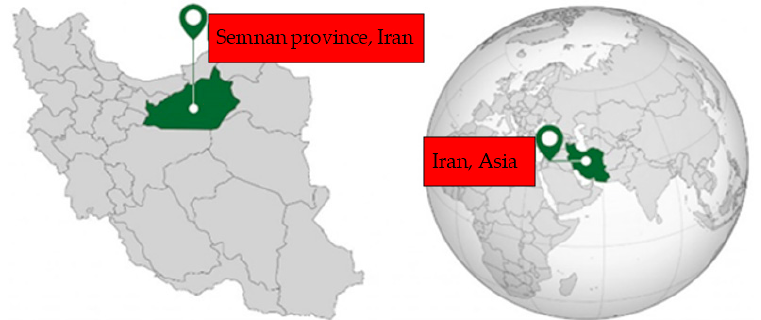
Figure 1. Road project location.